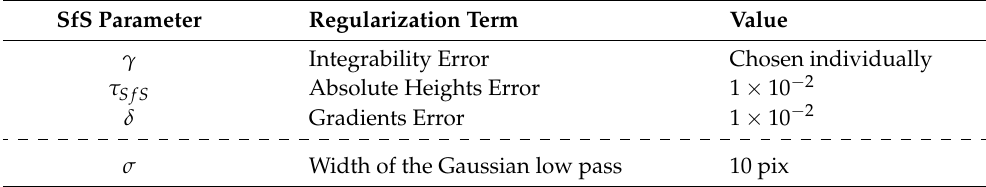
Table 2. Parameters for the regularization terms of the Shape from Shading (SfS) scheme. SfS